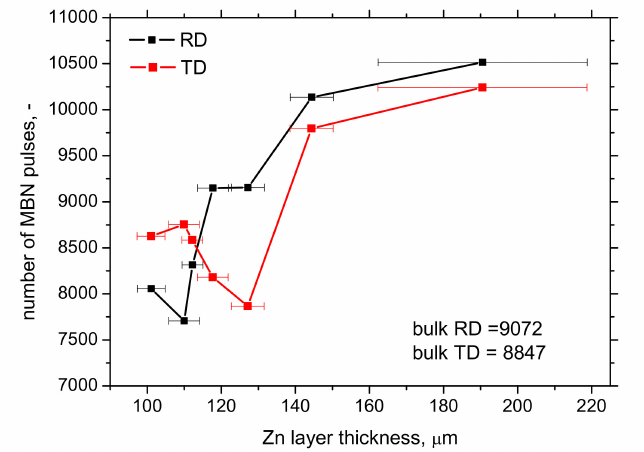
Figure 12. Evolution of the number of detected MBN pulses along with increasing Zn coating (layer) thickness (obtained from the MO).